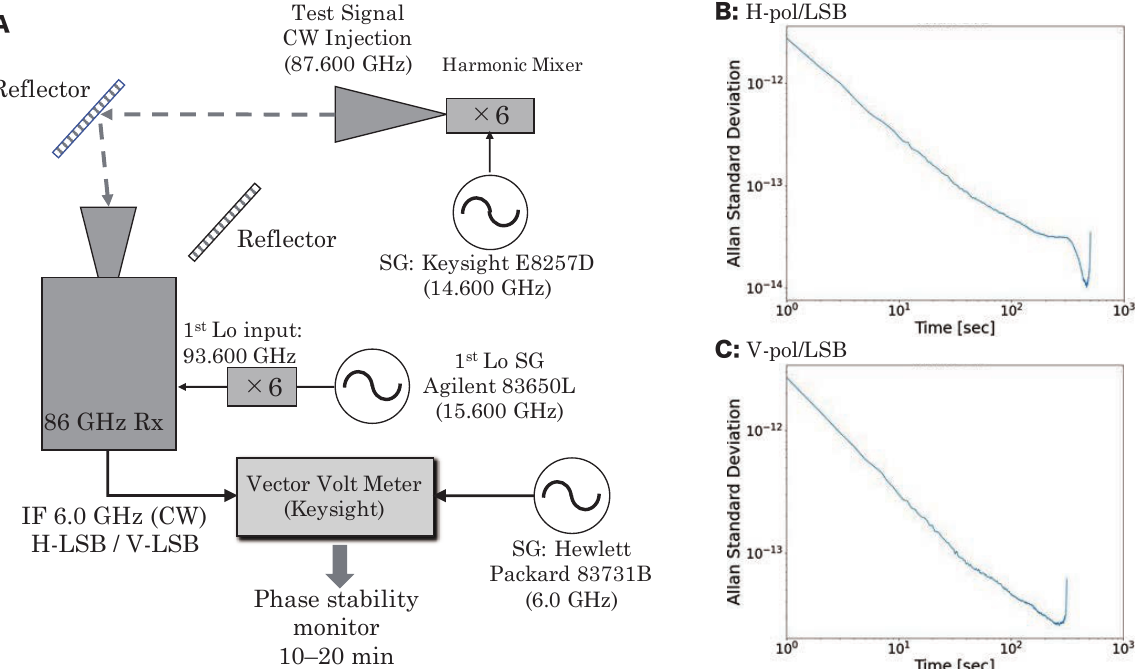
Figure 8. Schematic diagram of the measurement system for measuring the phase stability of the- 86 GHz receiving system established by HINOTORI ( A ), along with the ASD measured for the horizontal polarization ( B ) and vertical polarization ( C